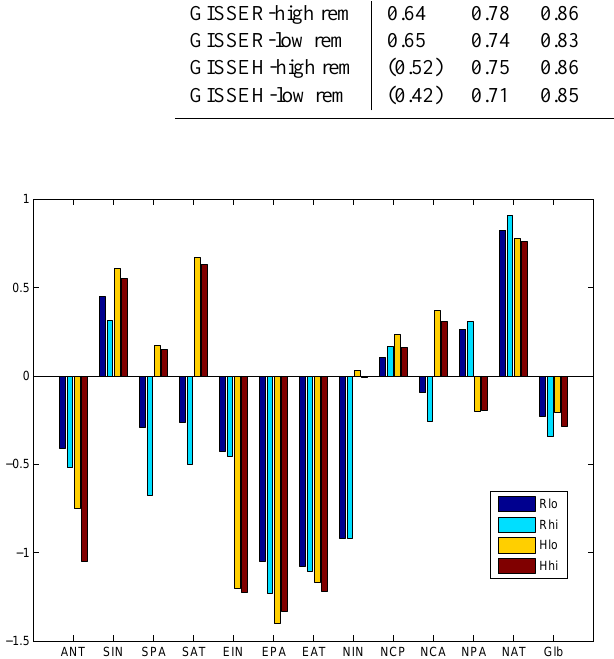
GISSER model but slightly decreases in GISSEH because mixing in GISSEH brings much less DIC near the surface.